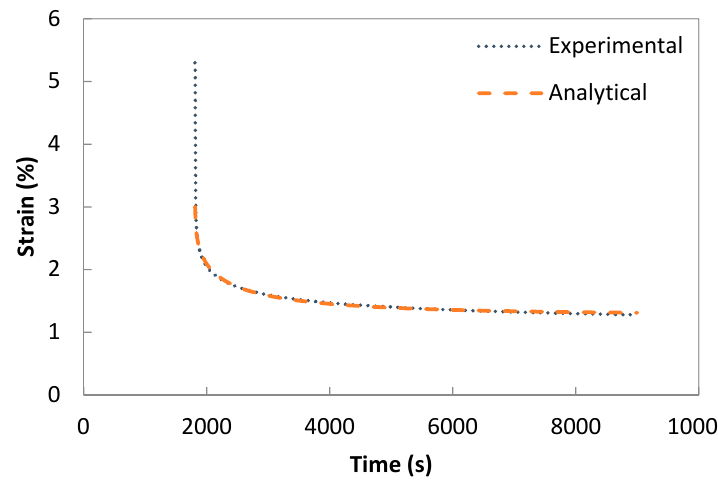
Figure 12. Modelling the recovery component of PB5 by a Weibull distribution function.